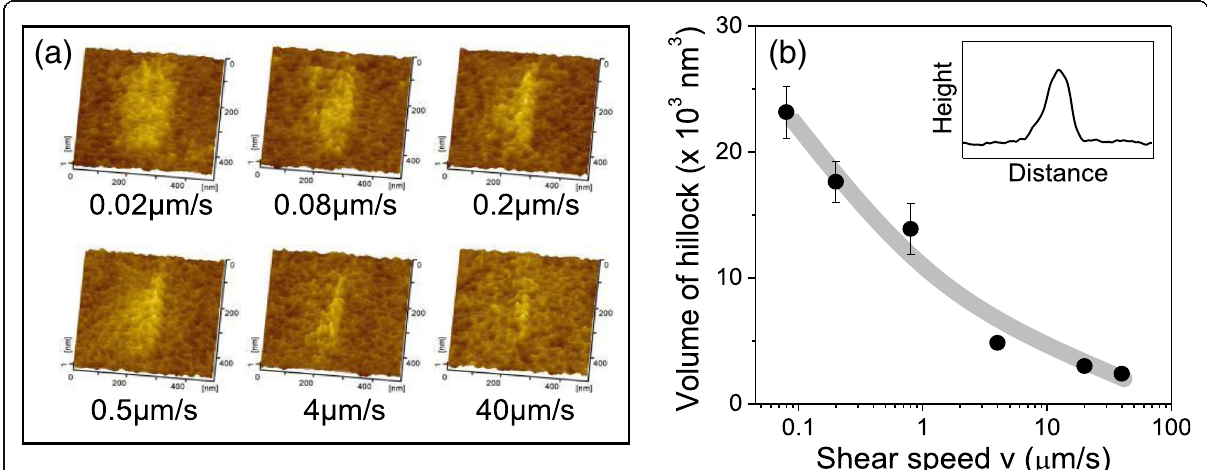
Fig. 2 Si wear as a function of sliding speed under dry air. Topography of the wear region ( a ). Volume of hillocks on Si surface formed after 100 sliding cycles in vacuum ( b ). Imposed load is 2 μ N, and sliding amplitude is 200 nm. Inset in ( b ) shows the diagram of the cross-section profile of a